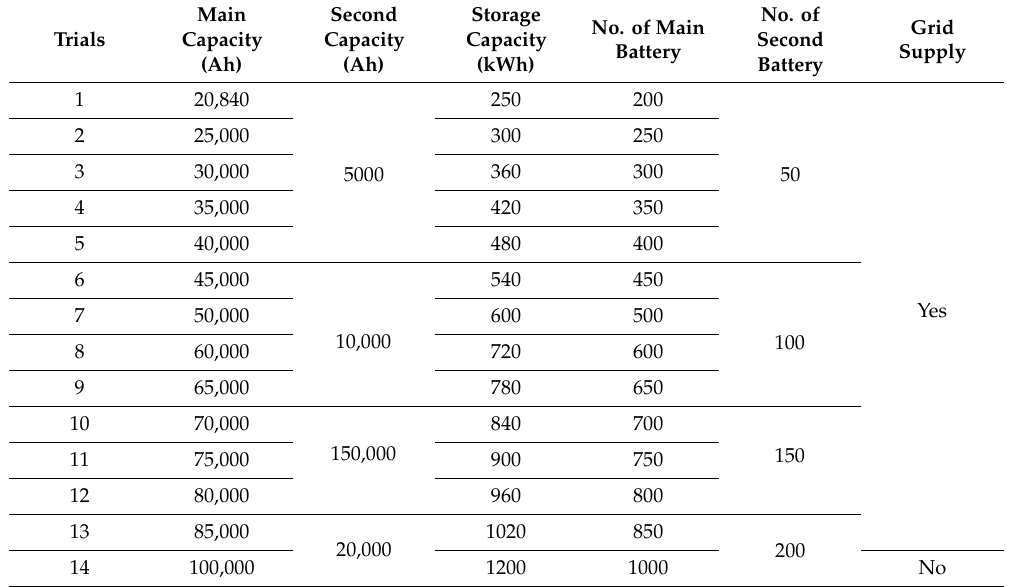
Table 5. Optimum battery size trials for smart energy